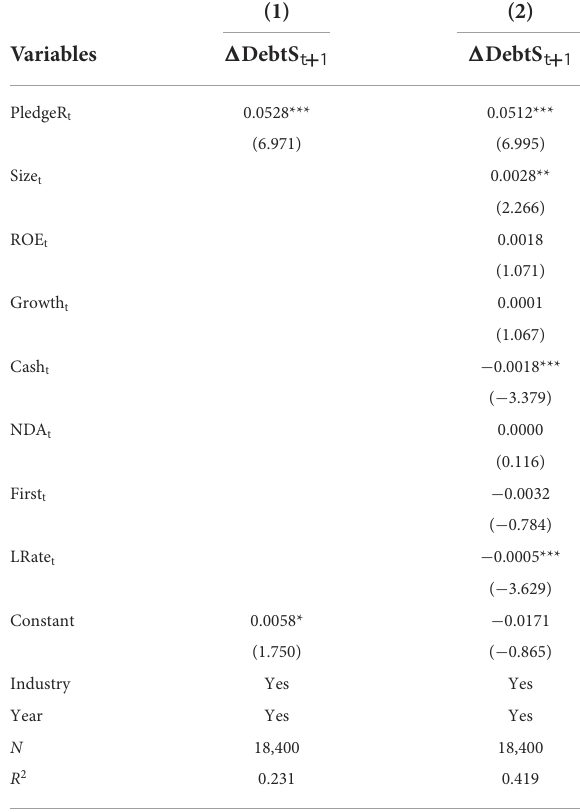
TABLE 9 Robustness: the regression results of changing debt maturity structure